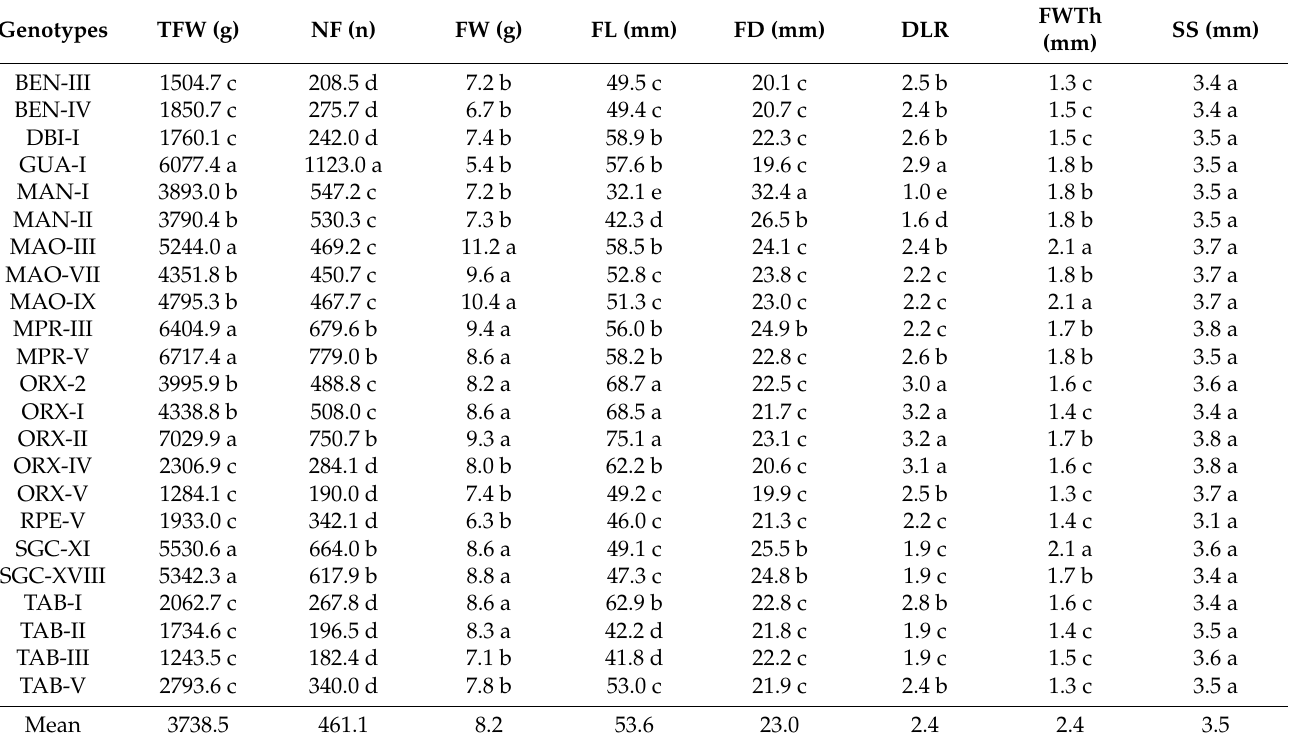
Table 2. Means of the traits total fruit weight per plant (TFW), number of fruits per plant (NF) and mean fruit weight (FW), evaluated in 25 weekly harvests, fruit length (FL), fruit diameter (FD), fruit length to diameter ratio (DLR), fruit wall thickness (FWTh) and seed size (SS) were evaluated in a sample of 15 fruits per plot of 23 “pimenta-de-cheiro” C. chinense genotypes.